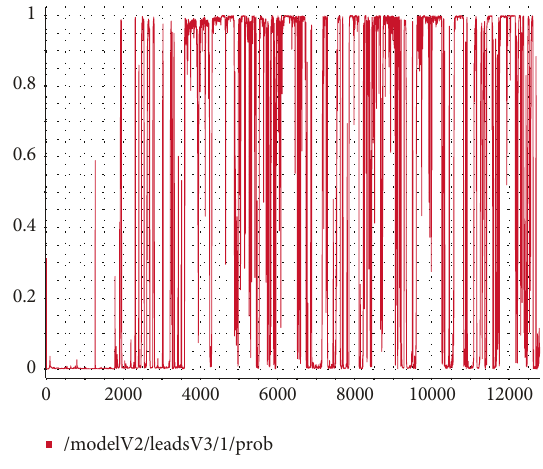
Figure 54: T2N1 lead car detection.